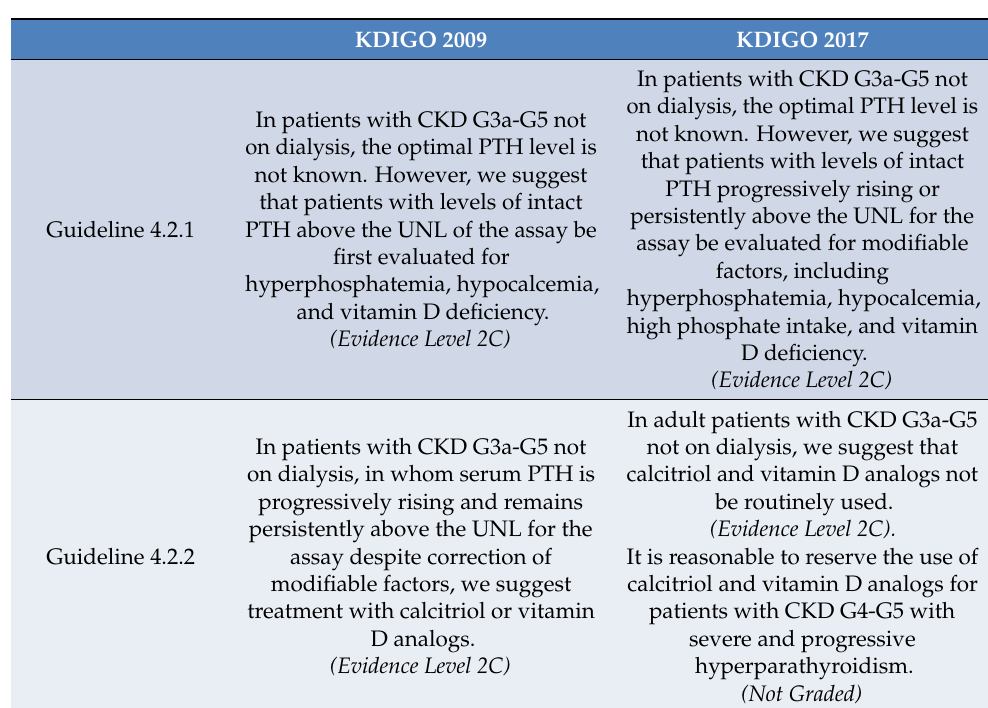
Table 1. Comparison of KDIGO guidelines 2009/2017 on treatment of abnormal PTH levels in non-dialysis patients. Adapted from reference